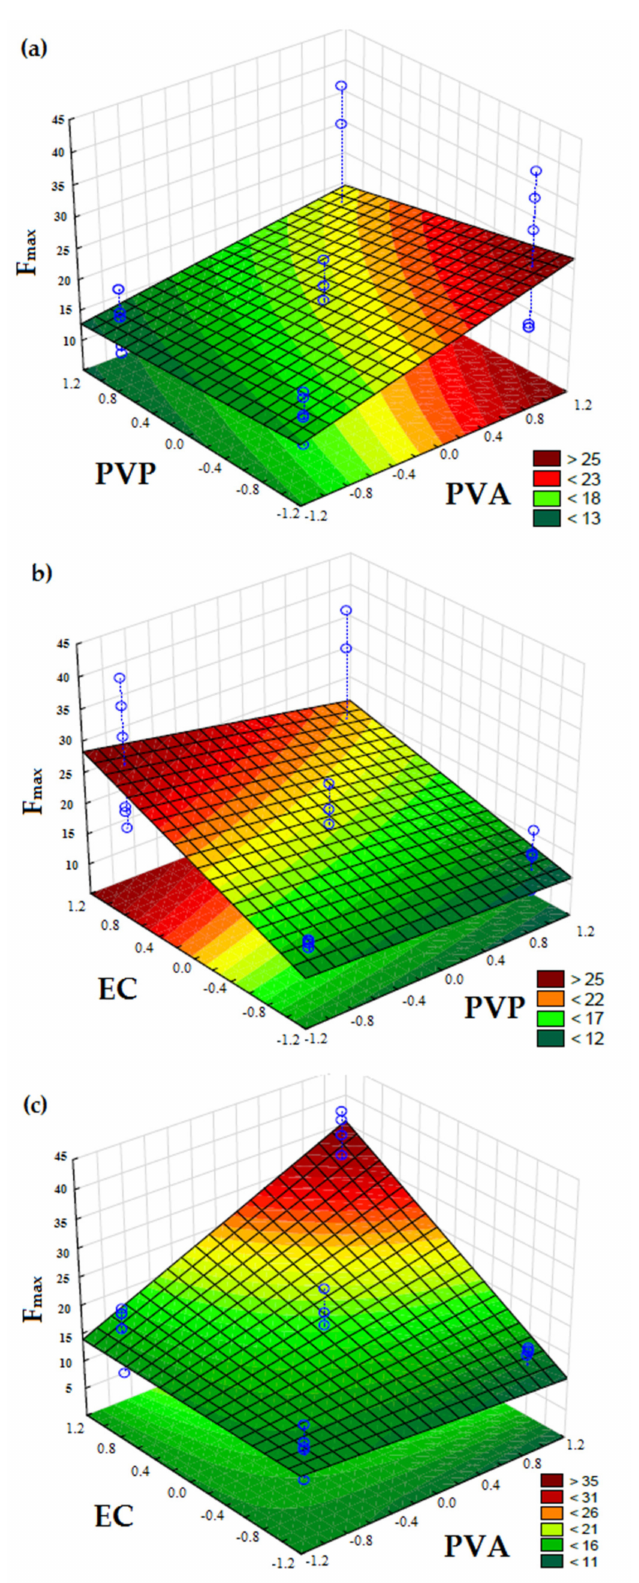
Figure 2. Response surface plots of mechanical tensional characteristic (F max ) of film formulations at 25 ◦ C as a function of: ( a ) PVA (X 1 ) and PVP (X 2 ); ( b ) PVP (X 2 ) and EC (X 3 ); ( c ) PVA (X 1 ) and EC (X 3 ). The color scale is indicated in each figure and shows the isoparametric